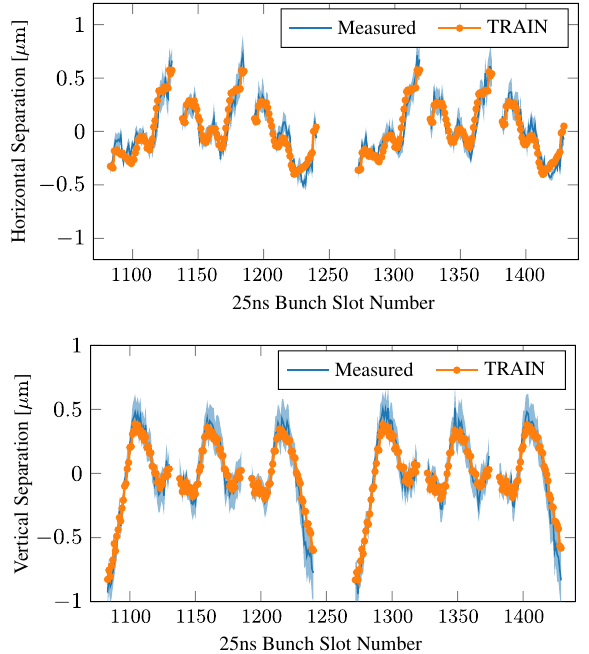
FIG. 18. Zoom on Fig. 17, showing two typical bunch trains colliding in all four IPs. The shapes predicted by the TRAIN simulation match the data within